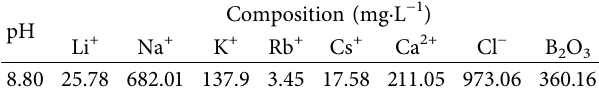
Table 1: Chemical composition of the geothermal water sample.